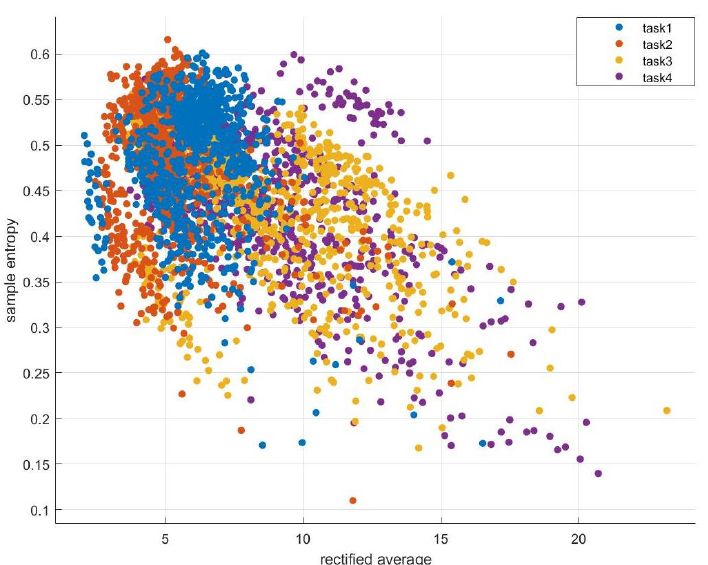
Figure 8. Scatter plot of the distribution of data points based on rectified average and sample entropy features.